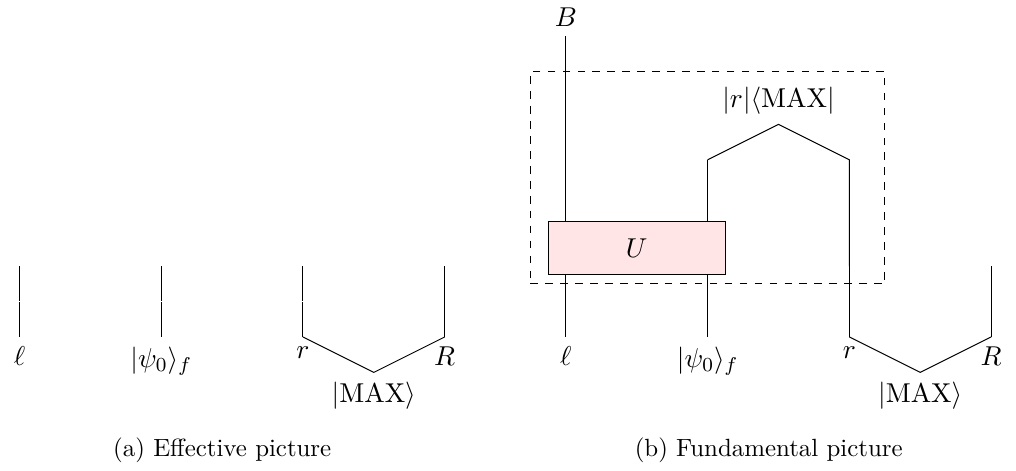
Figure 1. A simplified version of the model in ref. [1]. The part enclosed by dashed lines is the holograhic map V H